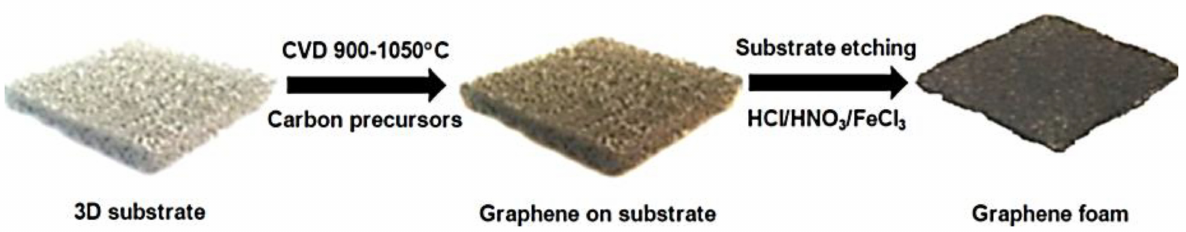
Figure 2. Schematic of synthesis of three dimensional graphene network through chemical vapor deposition. Reprinted with permission from Ref. [56]. 2022,